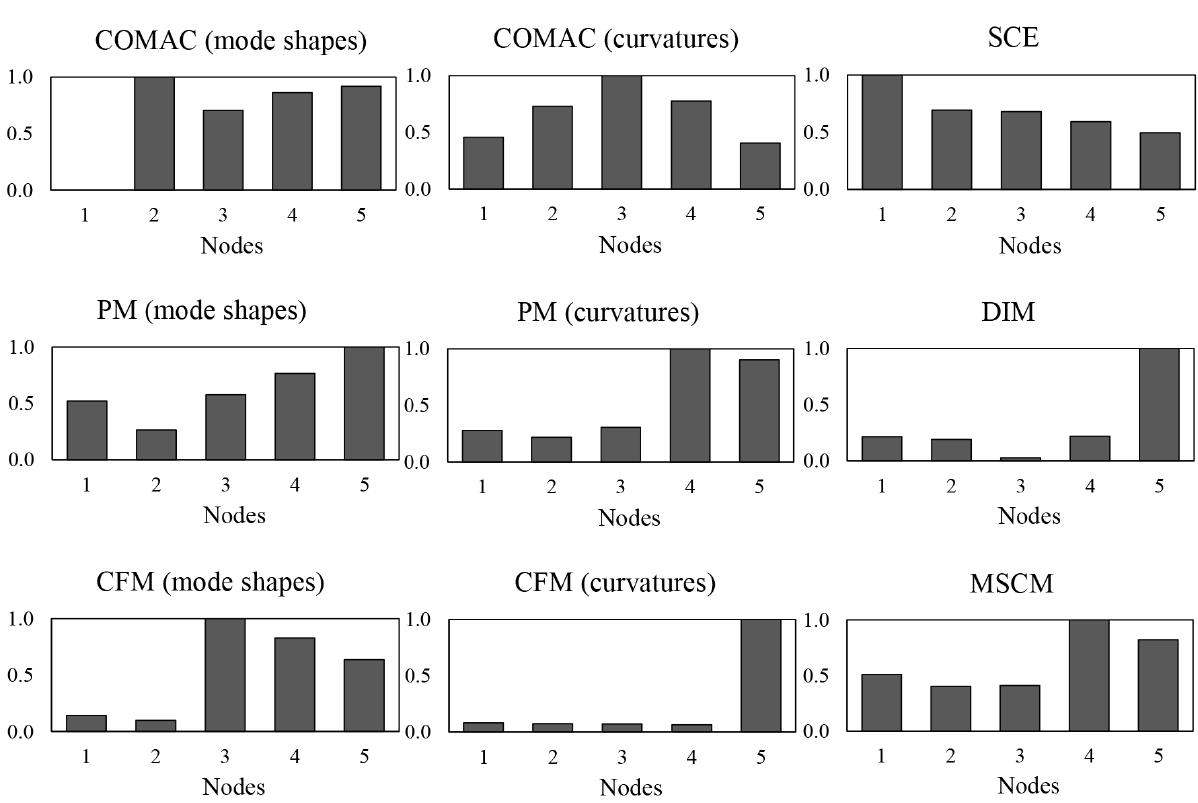
Figure 12. Damage localisation in x direction by selected modal-based